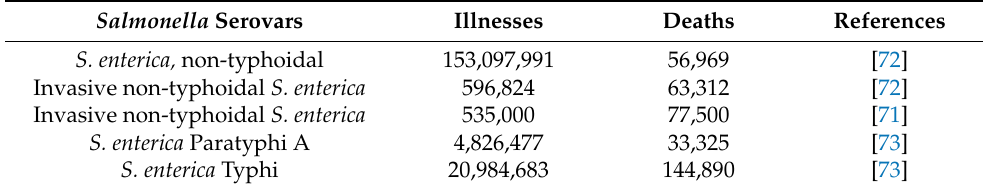
Table 4. Global Burden of salmonellosis. Salmonella